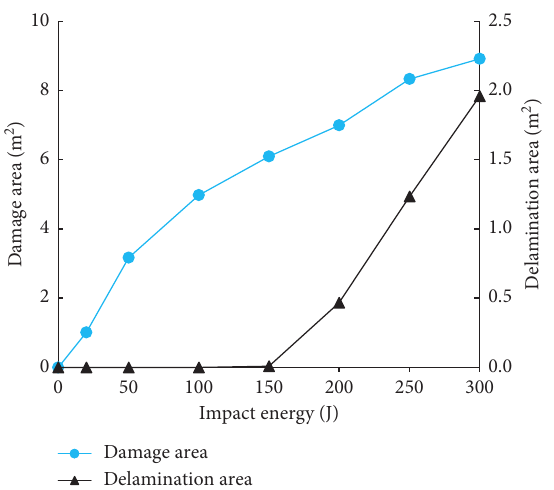
Figure 17: Damage area and delamination area vs. impact energy.